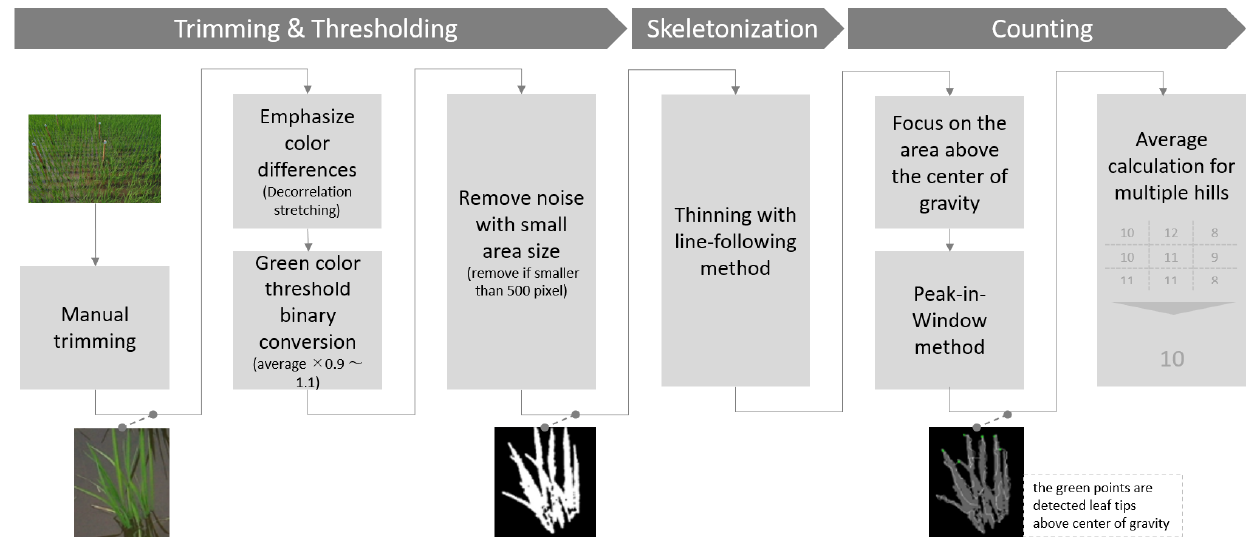
Figure 4. The overall process of image analysis.